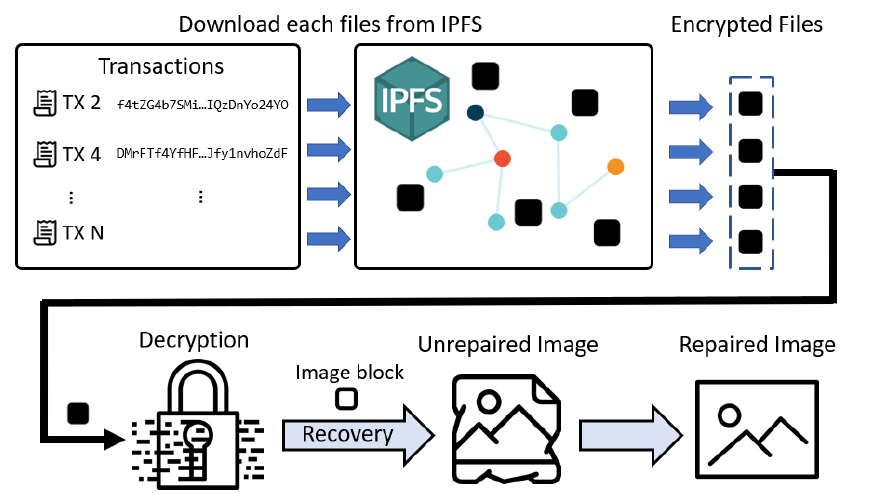
Figure 12. Process of image